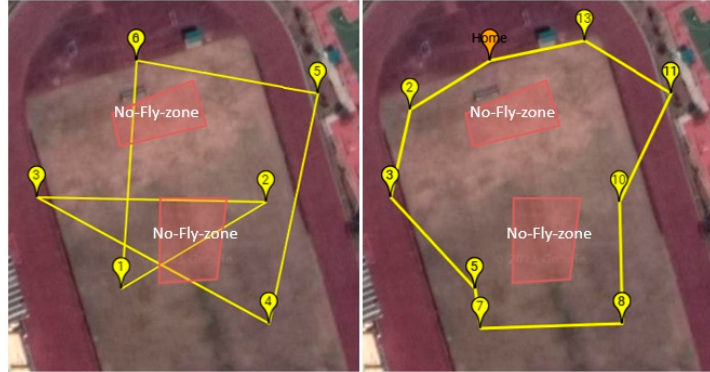
Figure 17. Flight trajectory for formation flight simulation.